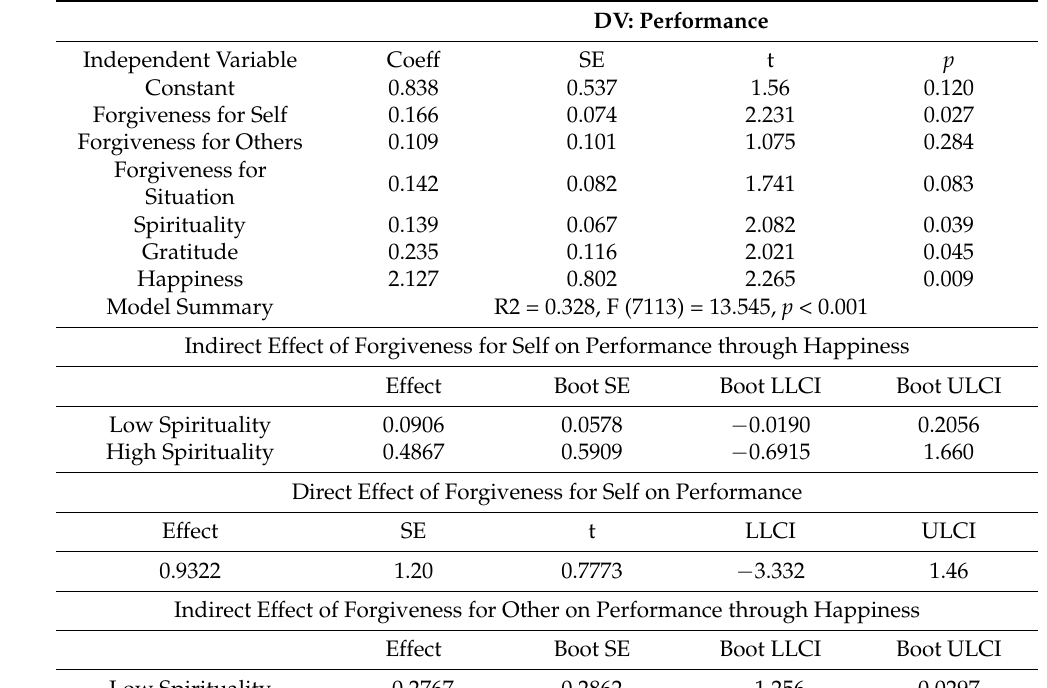
Table 5. PROCESS results for moderated-mediation hypotheses 3 and 4, dependent variable: perfor- mance using time 2